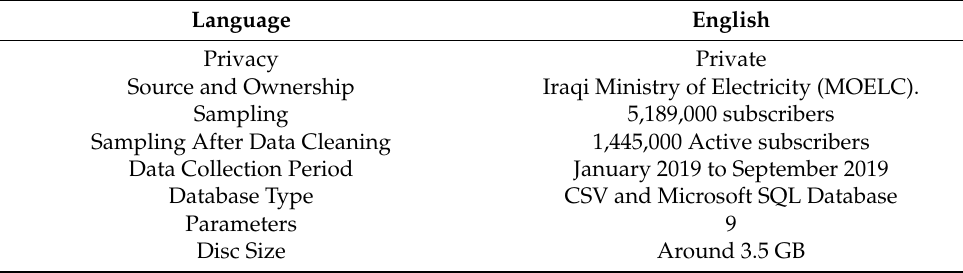
Table 2. Dataset Profile